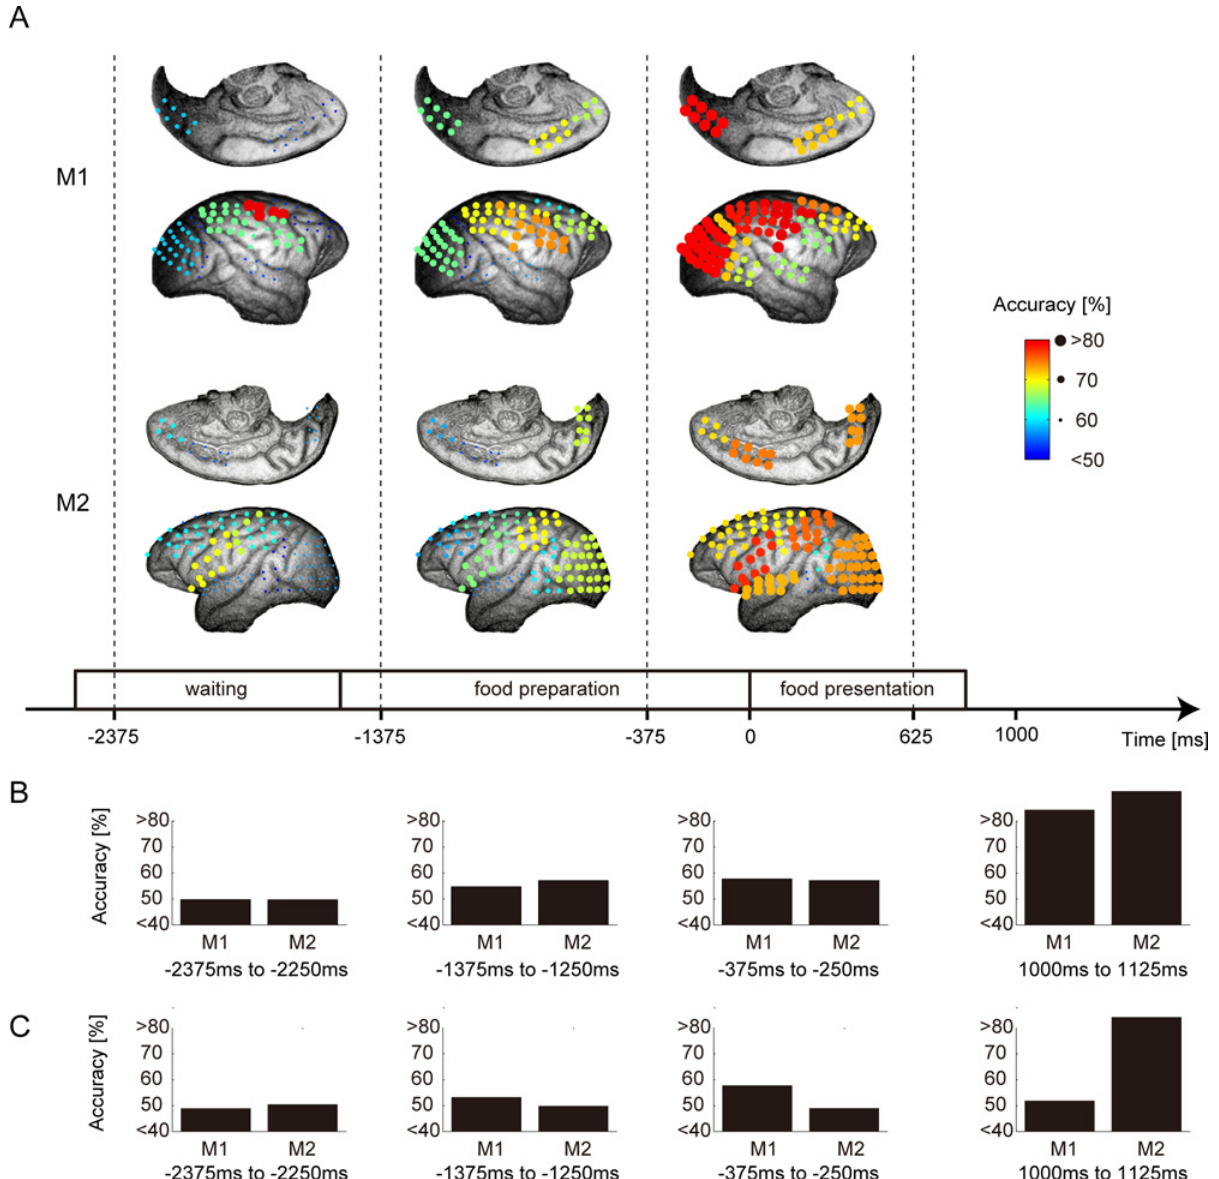
Fig 8. Comprehensive spatiotemporal pattern of the representation of social conditions. A: The spatial distribution of the accuracy of the spatiotemporal neural classifier in the conflict – contralateral condition for monkeys M1 and M2. The size and color of each circle are proportional to its accuracy. Three successive long time bins were selected from the waiting, food-preparation, and food-presentation periods (left, middle, and right). Dashed lines indicate the boundary of the long time bins. Numbers are shown relative to the start time of the food-presentation period under the time line indicating the start and end time of each long bin. B: The accuracy of the temporal neural classifier that discriminated whether the monkey used its right or left hand during the movement period for monkeys M1 and M2 during four time windows. C: The accuracy of the classifier that discriminated reward outcome from neural activity and outcomes of the preceding three trials during four time